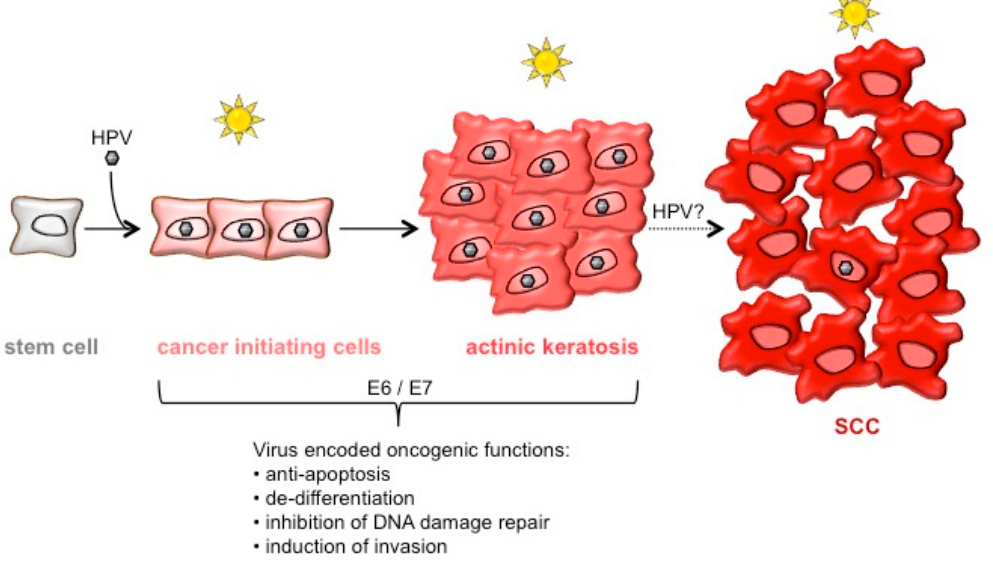
Figure 1. Model of keratinocyte transformation stages that may represent initial phases of betapapillomavirus ( β HPV)-induced squamous cell carcinoma (SCC) development. The accepted risk factor for SCC development is ultra-violet (UV)-irradiation. Infection with β HPV may play a carcinogenic role in the early phases of SCC development. The human papillomavirus (HPV)-mediated expansion of the stem cell pool may allow the generation of cancer-initiating stem cells, which can give rise to actinic keratoses. Yet unknown is the exact role of HPV in the progression of actinic keratoses to SCC, in which only few cells harbor viral genomes.